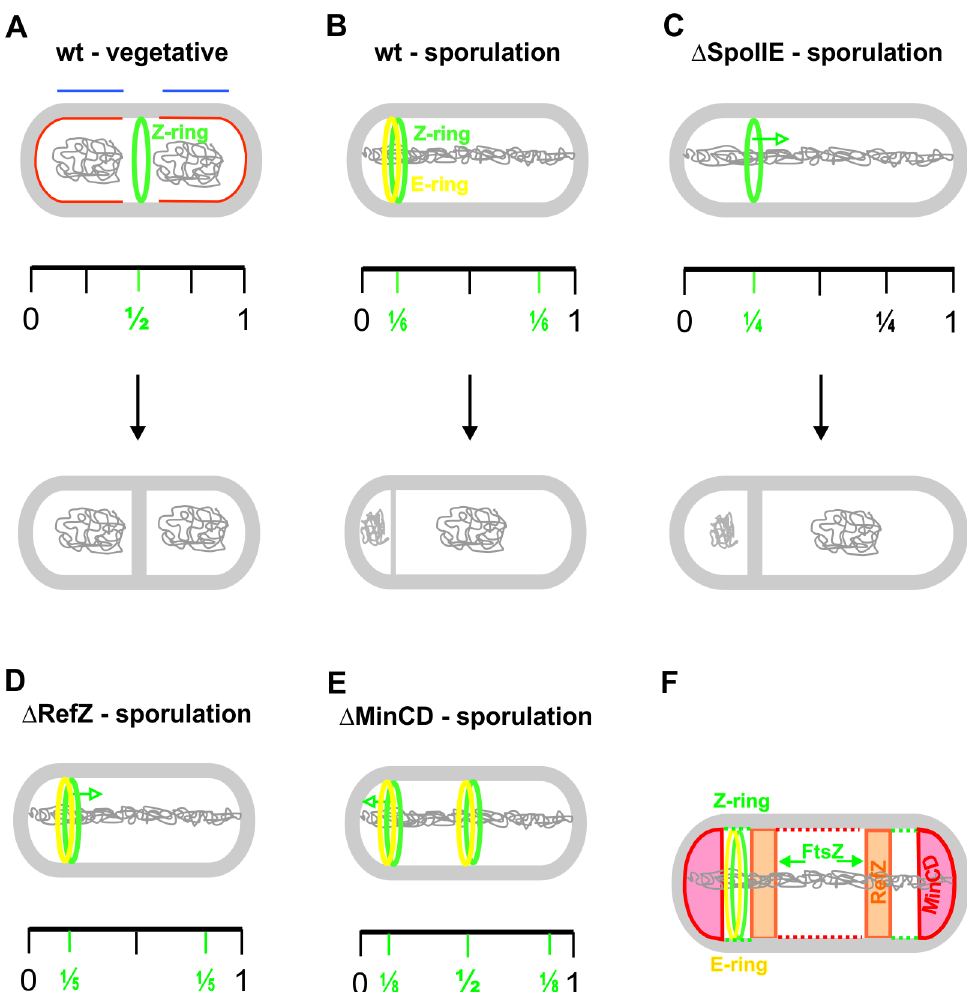
Fig 3. Models of division site positioning during vegetative growth and sporulation in B . subtilis . (A) During vegetative growth, upon initiation of DNA replication, the future division site is marked by a putative, but not yet identified, mid-cell defining factor. Upon segregation of the chromosomes (shown in grey inside of the cells), the nucleoid occlusion factors (blue lines above the nucleoids) clear the mid-cell site, while the Min system (shown in red) blocks Z- ring formation at the cell poles. The septum is formed with high precision at the mid-cell site. (B) During sporulation, the Z-ring forms approximately 1 / 6 of a cell length from one of the cell poles with high precision. In this cell cycle stage, the replicated chromosomes are in the form of axial filaments, and the Min system proteins are localized at the cell poles. It is not known how Z-ring formation prevails over the negative regulation of nucleoid occlusion and the Min system. (C) SpoIIE has a crucial role in precisely localizing the sporulation septum; in its absence, the asymmetric septum forms in an average of 1 / 4 a cell length from the nearest cell pole. This septum is thicker than the wild type sporulation septum and resembles the vegetative like septum. Δ SpoIIE cells cannot form spores. (D) RefZ has a moderate influence on the localization of the sporulation septum; in its absence the septation position moves farther from the cell pole, to an average position of 1 / 5 of the cell length. (E) MinCD influences the localization of the sporulation septum, and in cells lacking these proteins the septum position moves much closer to the cell pole, to an average position of 1 / 8 a cell length. In addition, cells lacking MinCD can also position the sporulation septum close to the mid-cell site, with lower frequency and precision. (F) This model shows how the Z- and E-ring can recognize the asymmetric site of septation within a narrow window formed by the negative cell division regulators RefZ and MinCD. However, the possible existence of an additional positive regulator, which helps to form the Z-ring specifically at this site cannot be ruled out.